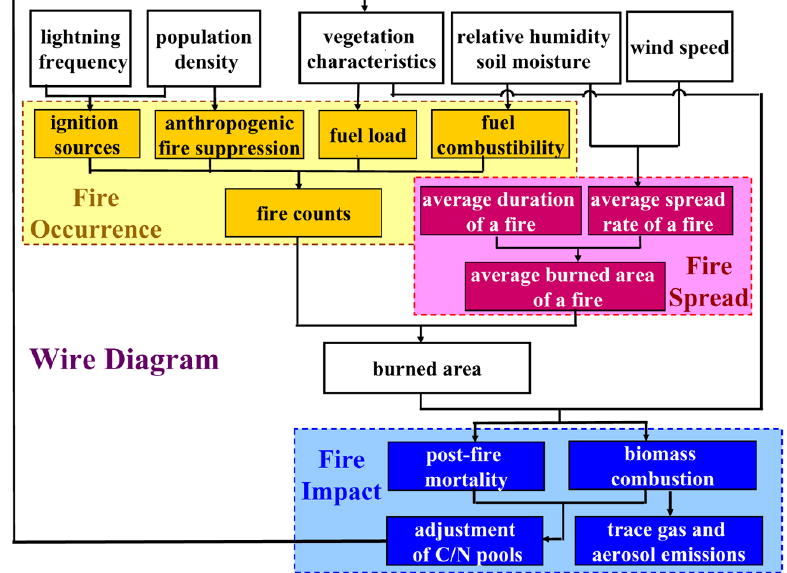
Fig. 2. Structure of the fire parameterization developed in the present study. Text boxes in yellow, red, and blue colors represent three parts in the fire module: fire occurrence, fire spread, and fire impact.